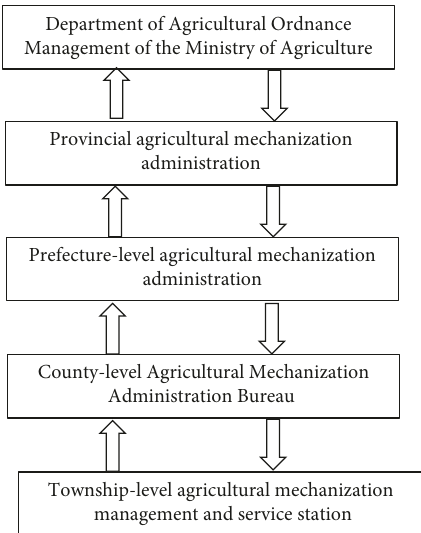
Figure 1: Structure composition of agricultural machinery management information system.